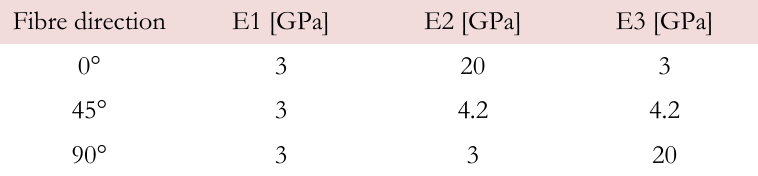
Table 1: Mechanical properties for numerical simulations.